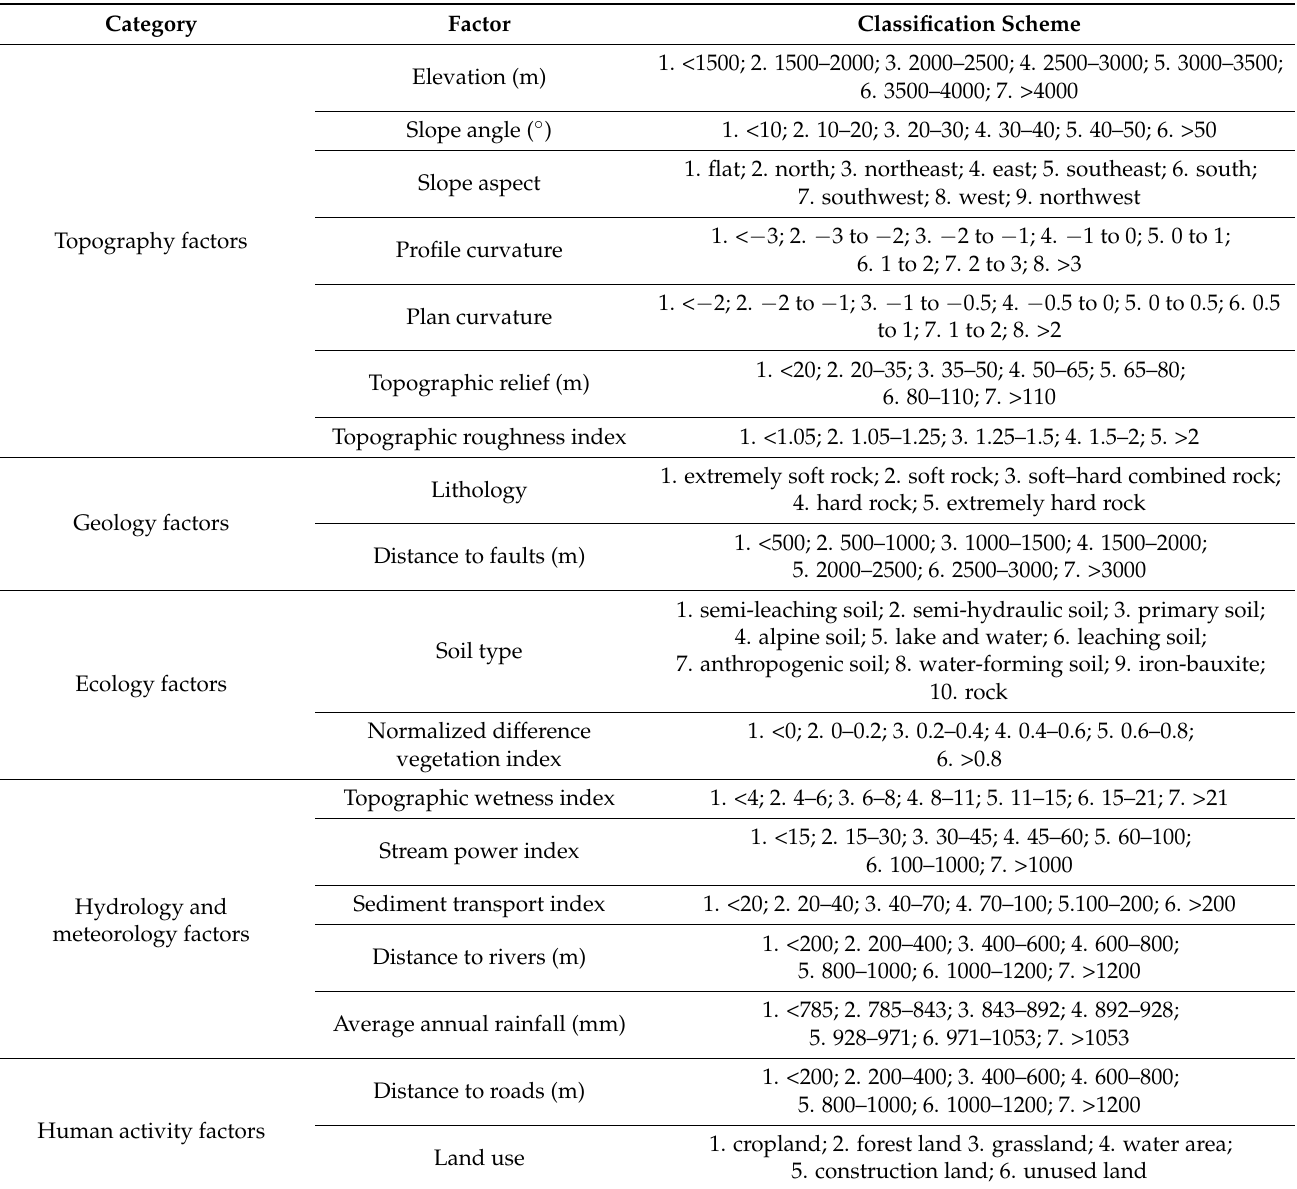
Table 3. Classification of landslide conditioning